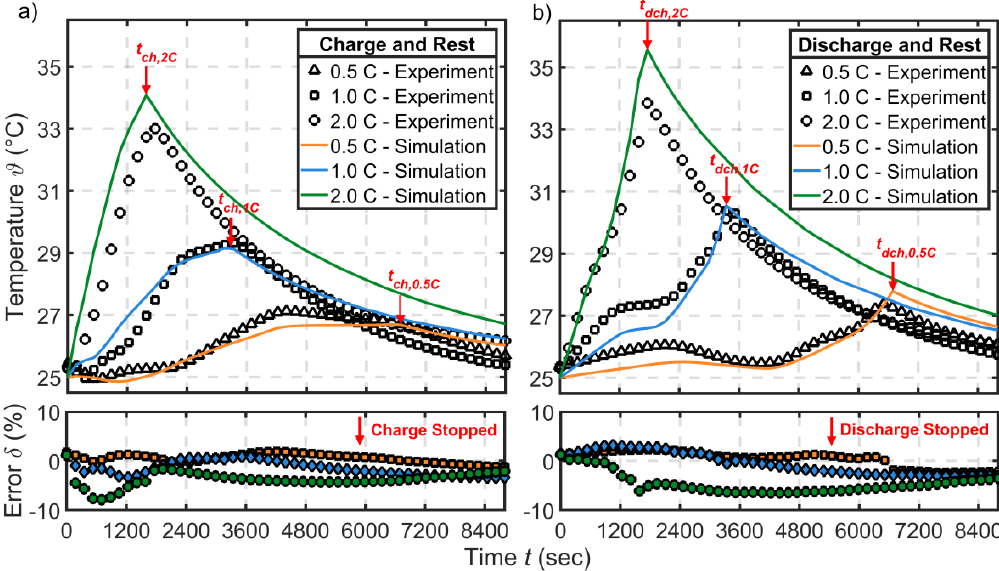
Figure 7. The maximal mean experimental surface temperature ϑ ( ◦ C ) , the average simulated surface temperature ϑ ( ◦ C ) and the relative error δ ( % ) during ( a ) charge and rest phases and ( b ) discharge and rest phases dependent on the current rates 0.5 C, 1.0 C and 2.0 C are shown as a function of time t ( sec ) . The ends of the charge times are denoted by t ch and the ends of discharge times are denoted by t dch ; each associated with the corresponding current rate. The reader is referred to Figure 5 for a closer look on the test conditions.